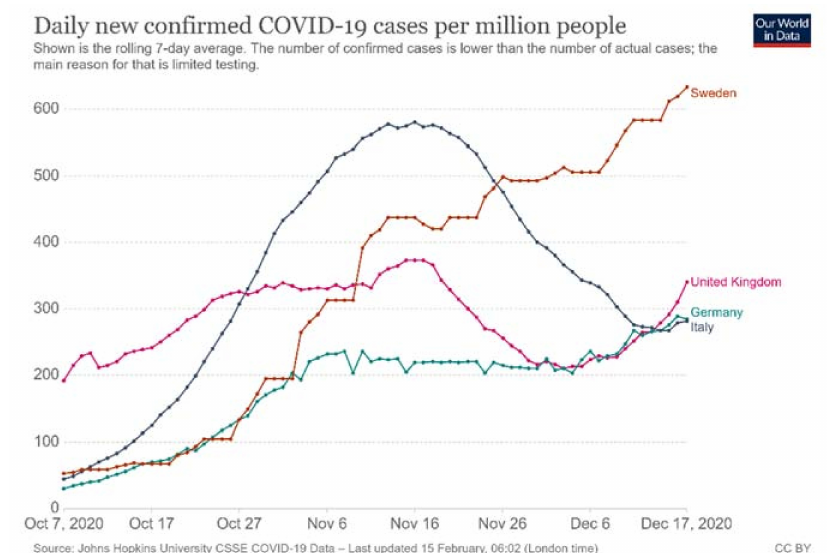
Figure 1. Daily confirmed COVID-19 cases during 7 October–7 December 2020.